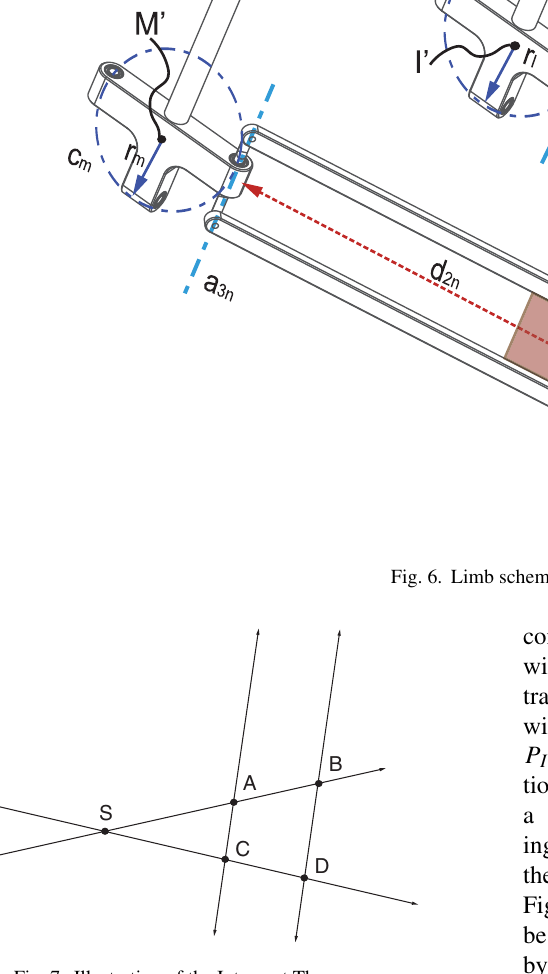
Fig. 7. Illustration of the Intercept